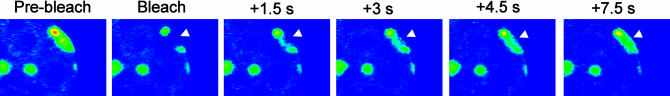
FRAP of HP1–GFP Reveals a Dynamic Association with HeterochromatinA fraction of a heterochromatic cluster (arrowhead) was bleached by a laser pulse, and recovery of fluorescence was monitored by time-lapse imaging. Images were kindly provided by Thierry Cheutin and Tom Misteli.